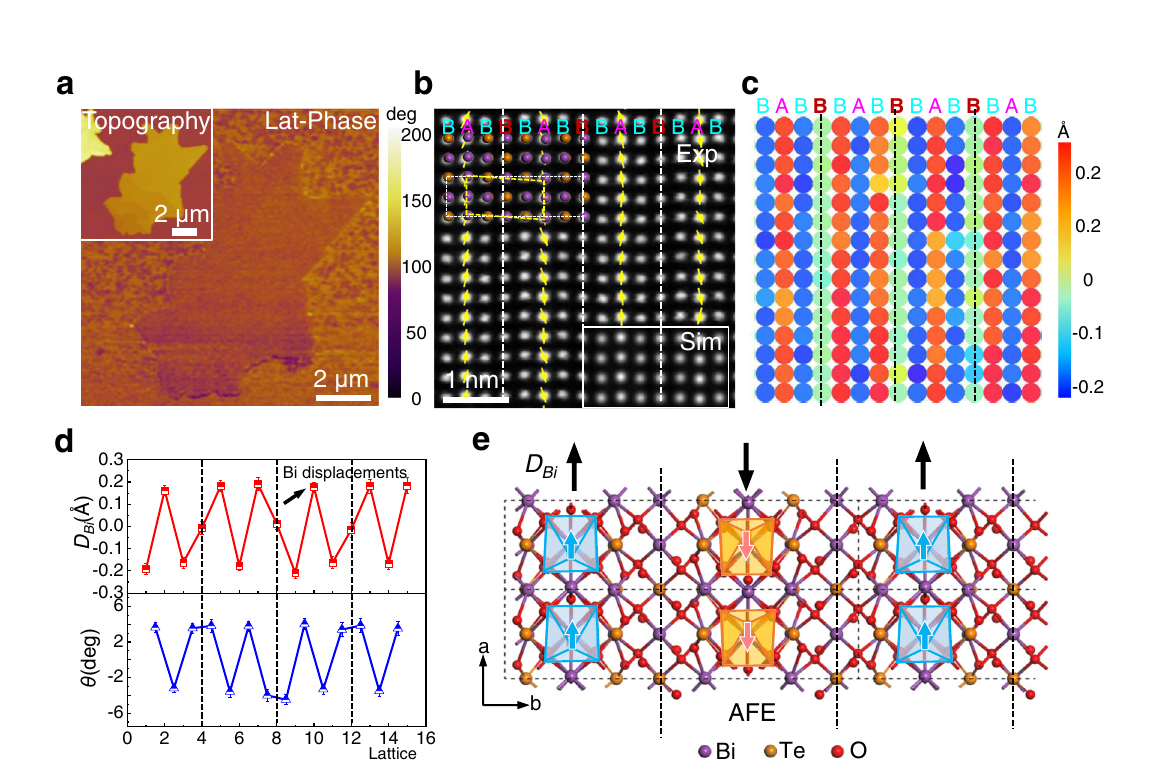
e – h CalculatedBi 3+ displacementscolormapof a – d .Theupanddownpolarizations are marked with red and blue areas, respectively.